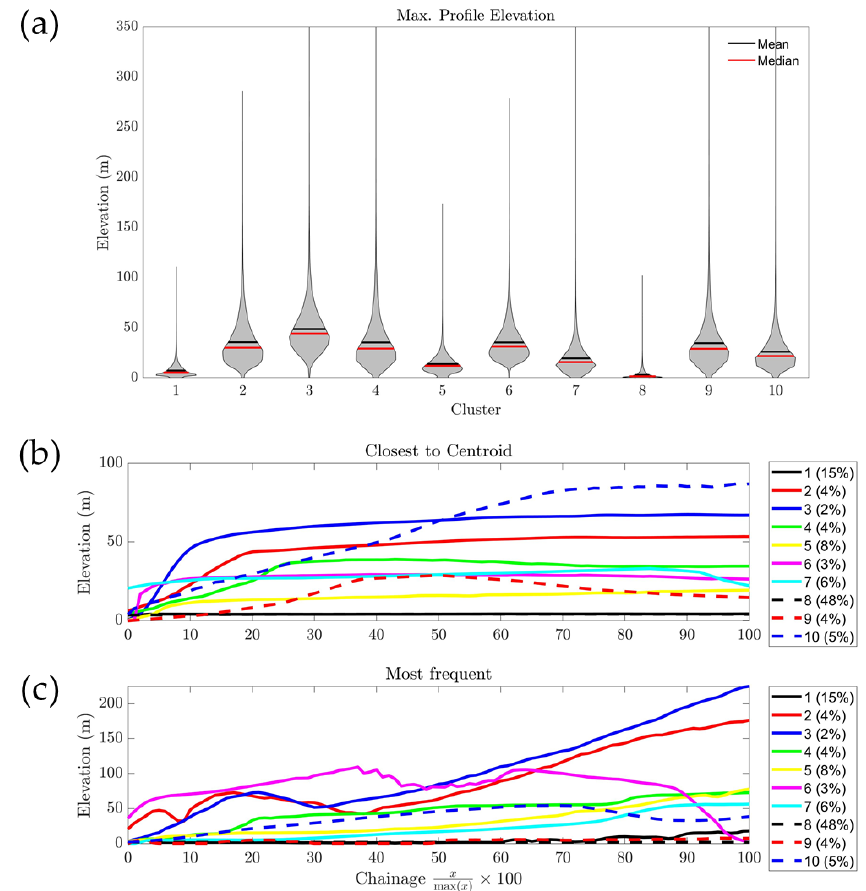
Figure 10. Statistical comparison between clusters: ( a ) violin plot of maximum elevation per cluster; ( b , c ) elevation profiles for each cluster showing the profile closest to the centroid ( b ) and most frequent profile ( c ). The percentage of profiles belonging to each cluster is shown in parentheses in the legend together with the cluster number.